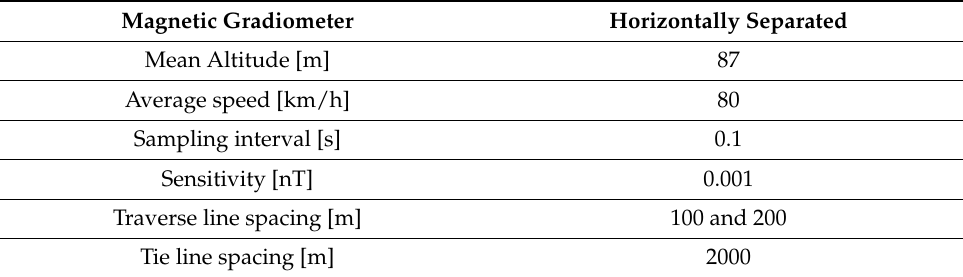
Table 1. Magnetic gradiometer properties